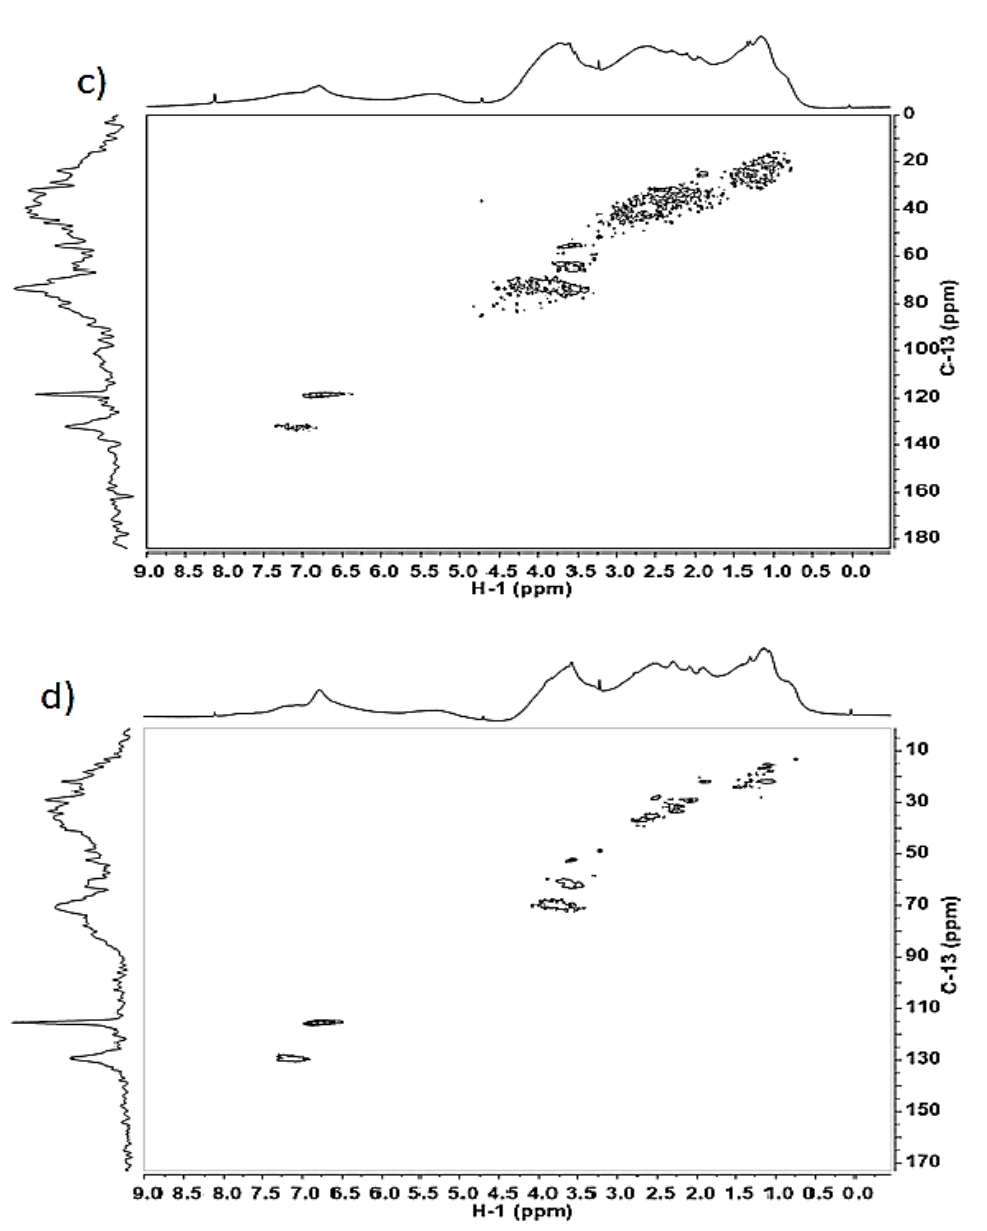
Figure 6. 1 H- 13 C HSQC NMR spectra of ( a ) PPL-DOM SAS 1A S, ( b ) PPL-DOM SAS 1A B, ( c ) PPL-DOM SAS 2A S, and ( d ) PPL-DOM SAS 2A B. Five specific spectral regions are highlighted in the spectrum of PPL-DOM SAS 1A S: Region I (blue)—Aliphatic moieties; Region II (red)—CRAM fraction; Region III (green)—ethers and esters; Region IV (yellow)—carbohydrate moieties; Region V (purple)—aromatic molecules.